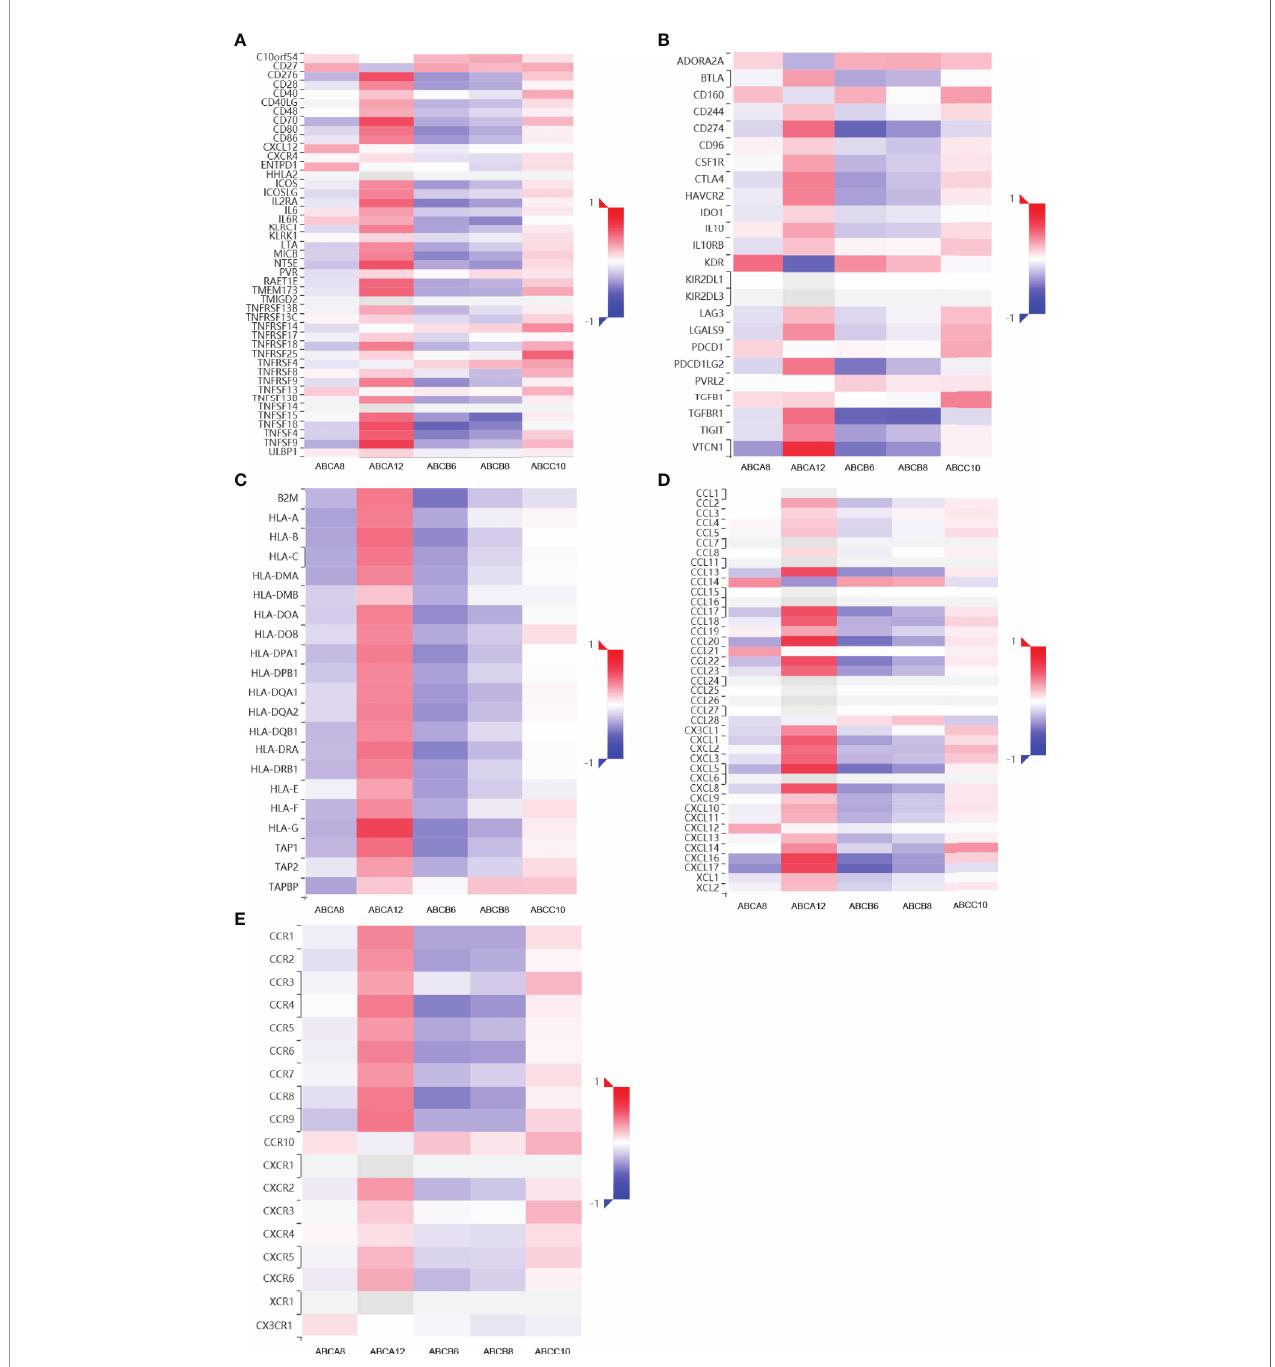
FIGURE 3 | Immunomodulatorsand chemokines-associatedanalysis of the hallmark ABC transportersin TC. (A – C) Correlation between the expression levelsof hallmark ABC transportersandimmunomodulatorsin TC. (D,E) Correlation between the expression levelsof hallmark ABC transportersand chemokine ligands andreceptors in